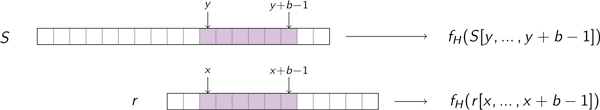
Fingerprint computation on b-length substrings. When looking for overlaps between S and r, the fingerprints are computed on the substrings r[x, . . ., x+b -1] and S[y, . . ., y + b - 1], respectively, where x and b are set before the contig's extension phase. We require an (almost) exact b-length match between r and S in order to include r in the set of putative overlapping reads, by setting fH (r[x, . . ., x + b - 1]) = fH (S[y, . . ., y + b -1]). Using such a method, the suffix-prefix overlaps that can be detected are those of length l ≥ x + b.